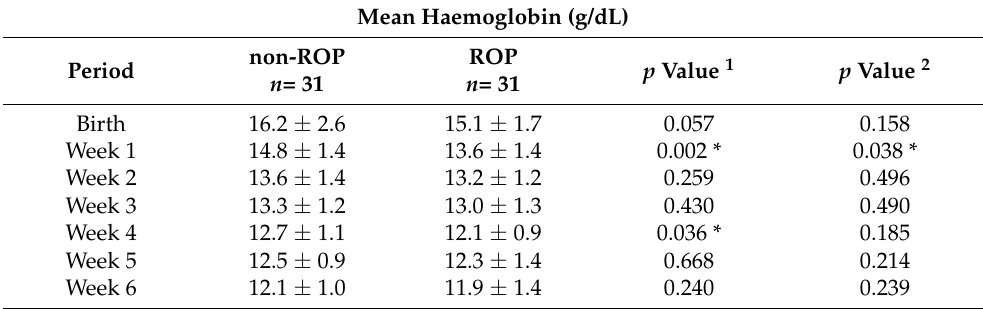
Table 2. Comparison of weekly mean haemoglobin between ROP and non-ROP groups.